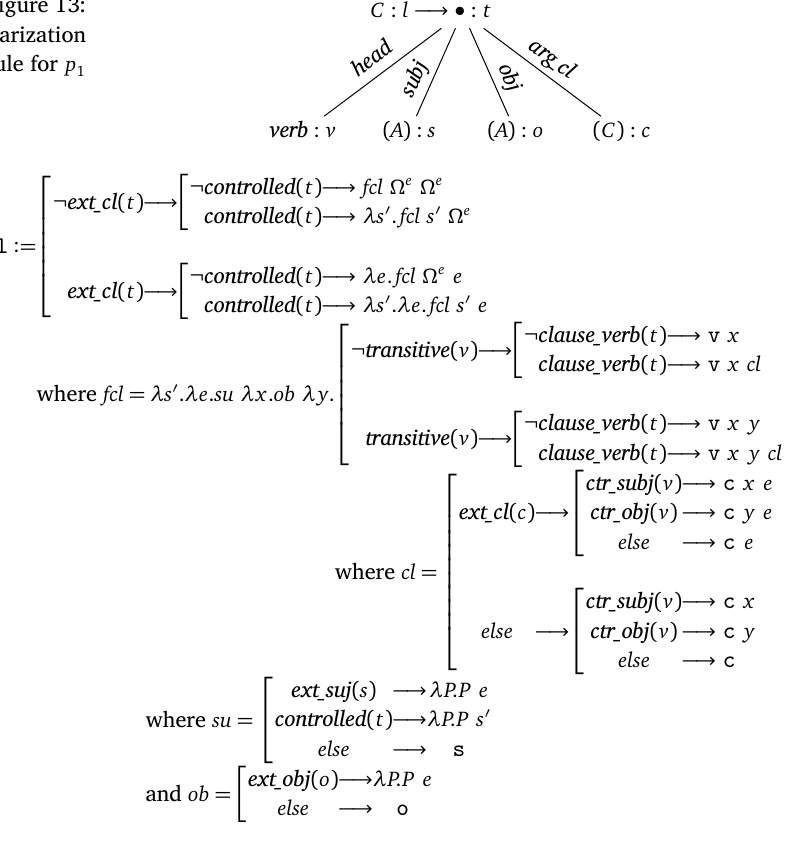
Figure 13: Semantic linearization rule for p